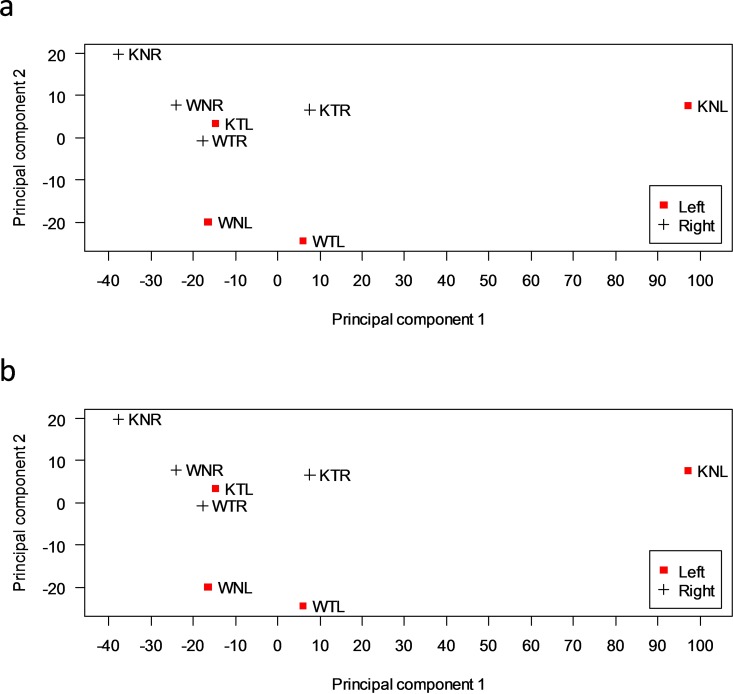
Principal component analysis (PCA) is used to cluster the conditions with gene expression levels for (a) all genes, (b) 5282 genes that are differentially expressed in at least one of comparisons listed in Table 1.Each point corresponds to the gene expression pattern generated by an experimental group projected onto the two-dimensional principal component space.